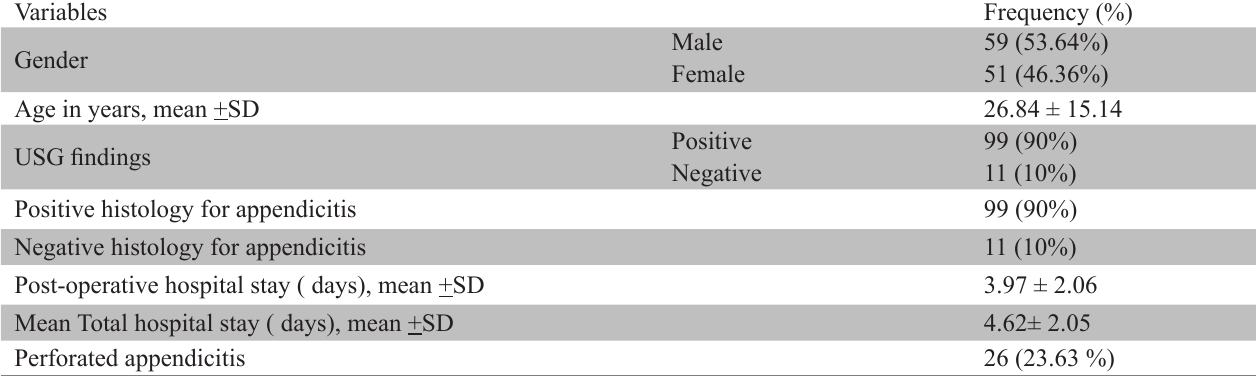
Table 2. Demographic and clinical characteristics of the patients (n = 110)